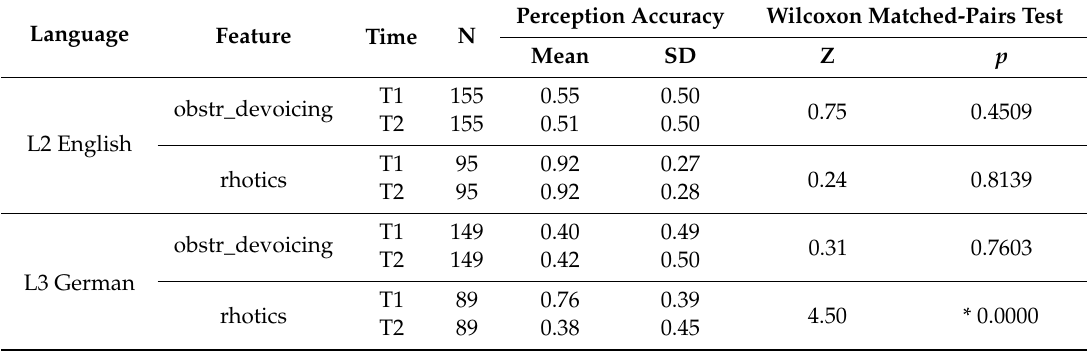
Table 3. Perception accuracy for second language (L2) and third language (L3) at testing time one (T1) and testing time two (T2).